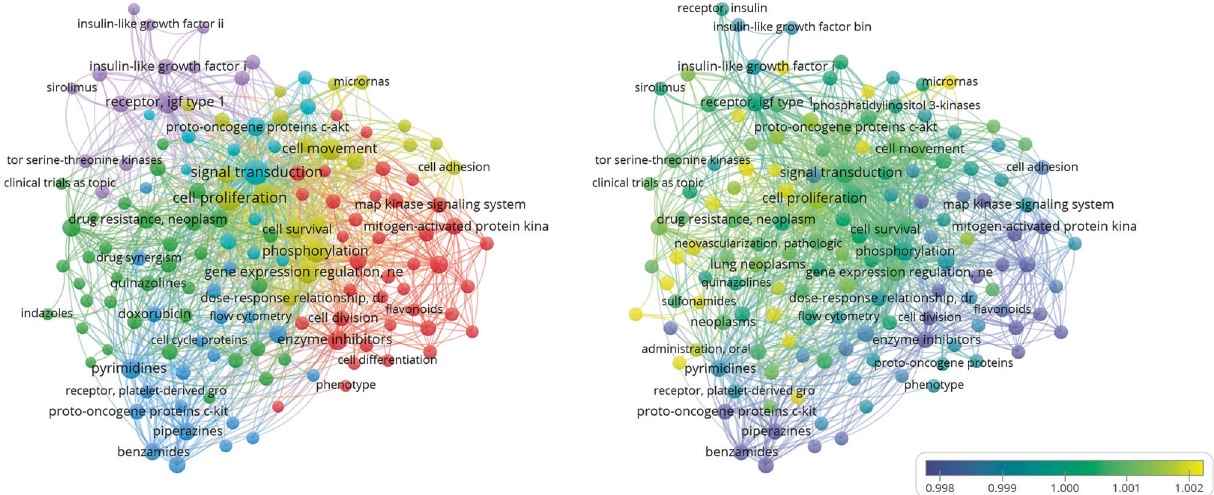
Fig. 2 PubMed database was used to search literature related to OS and TKIs from 2000 to now, and the visual image of keyword distribution frequency was drawn, which showed that studies on TKIs in OS mostly focused on signal transduction, which was consistent with the action mechanism of TKIs. Keywords with the highest correlation included imatinib, IGF-1R, platelet-derived growth factor (PDGF), PI3K inhibitors, MAPK signaling pathway,